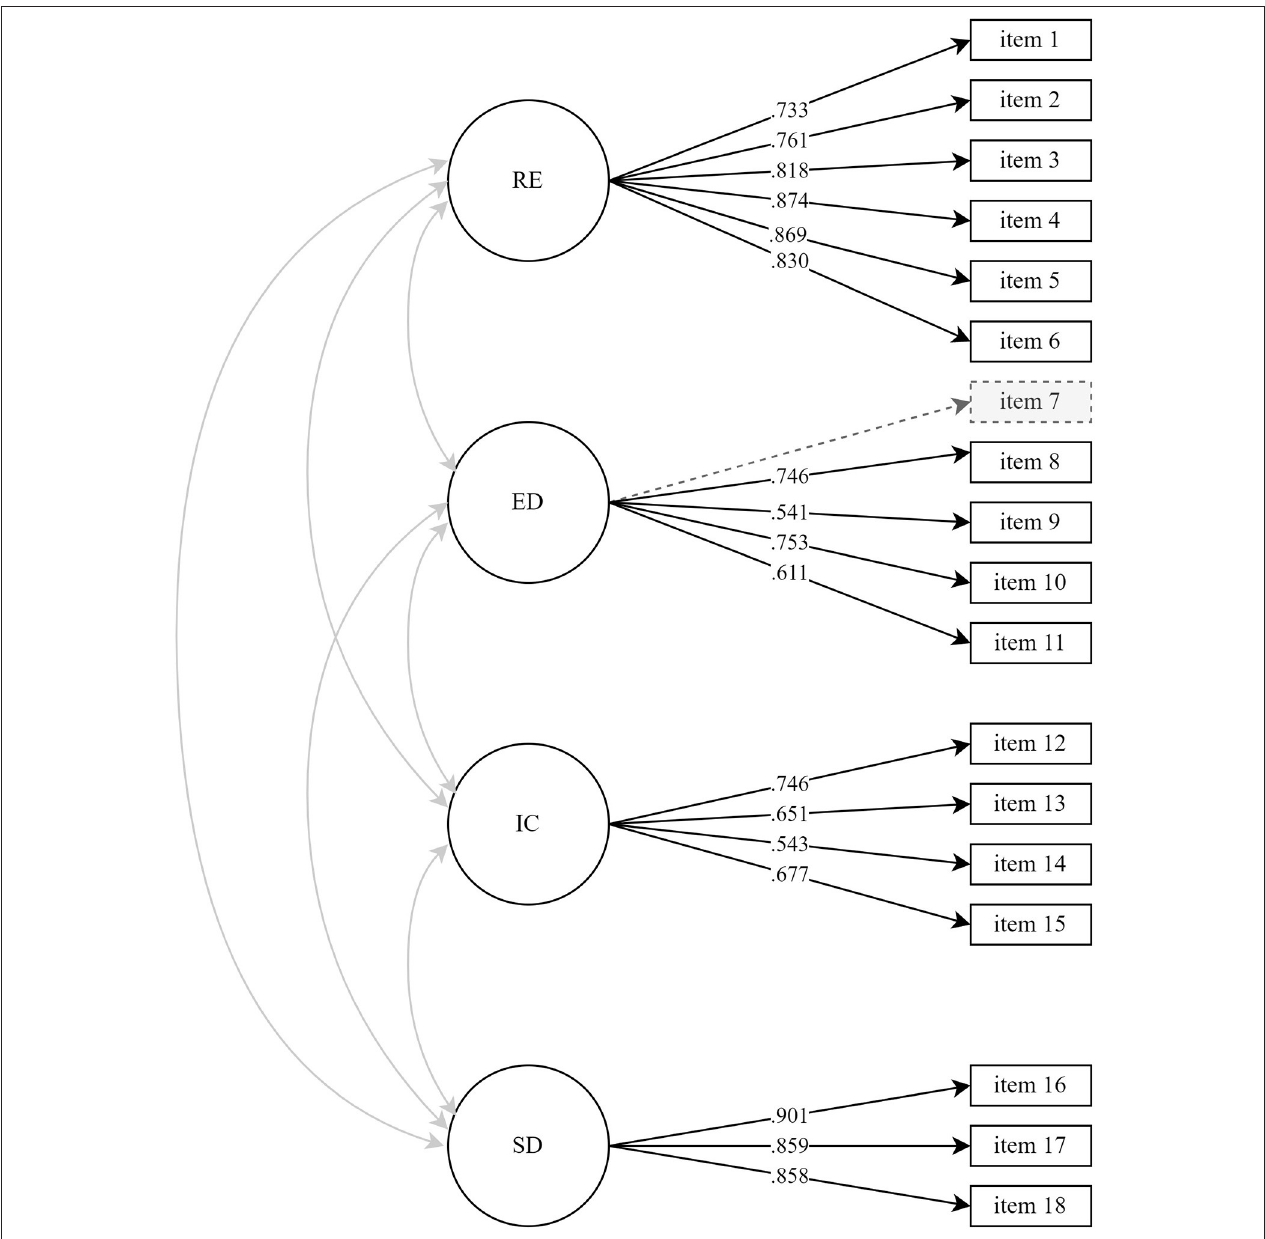
FIGURE 2 | Final 4 -factor model post-transition questionnaire (W2) with standardized estimates. The dotted markings are changes from the conceptual model, indicating removal of item 4. RE, reconsideration; ED, exploration in-depth; IC, identification with commitment; SD, self-doubt. n = 1,191.